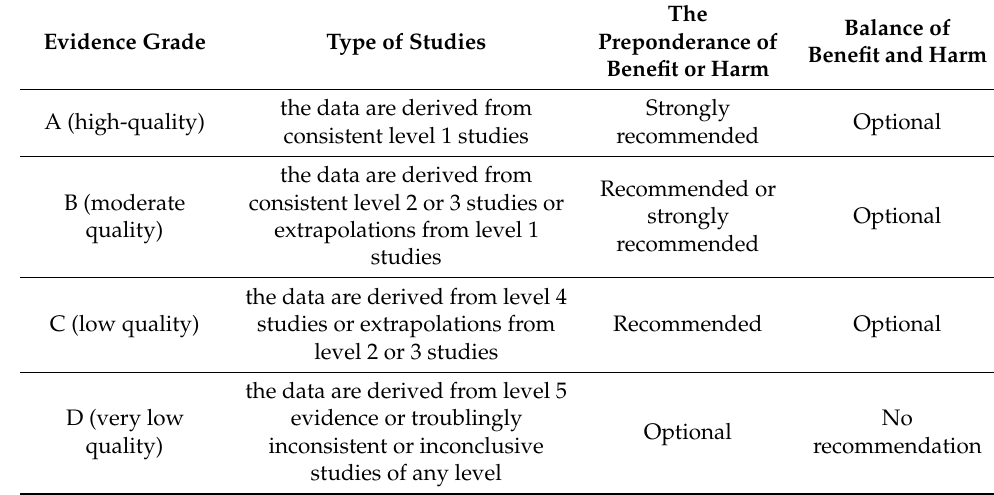
Table 4. Determination of recommendations’